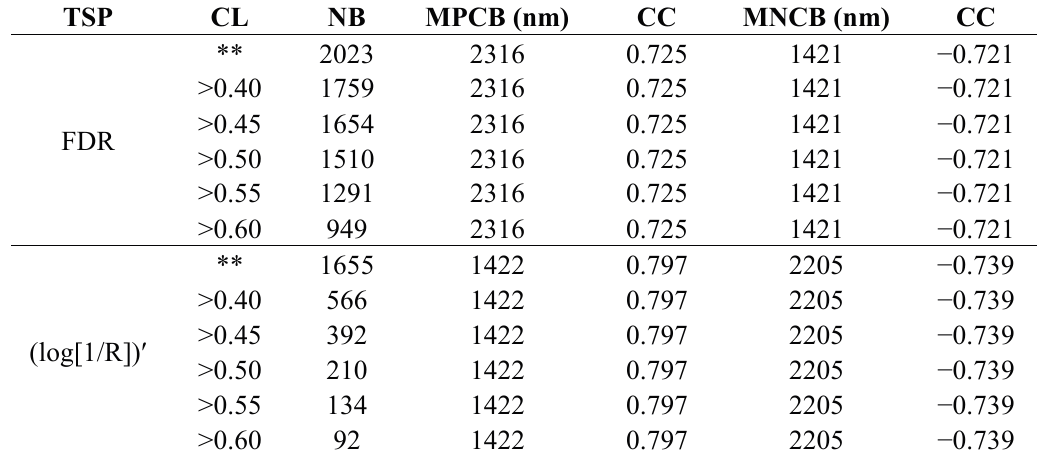
Table 5. Comparisons of the optimal correlative curve (OCC) of the first derivative differential (FDR) and the first derivative differential of reciprocal logarithm (log[1/R]) ′ .